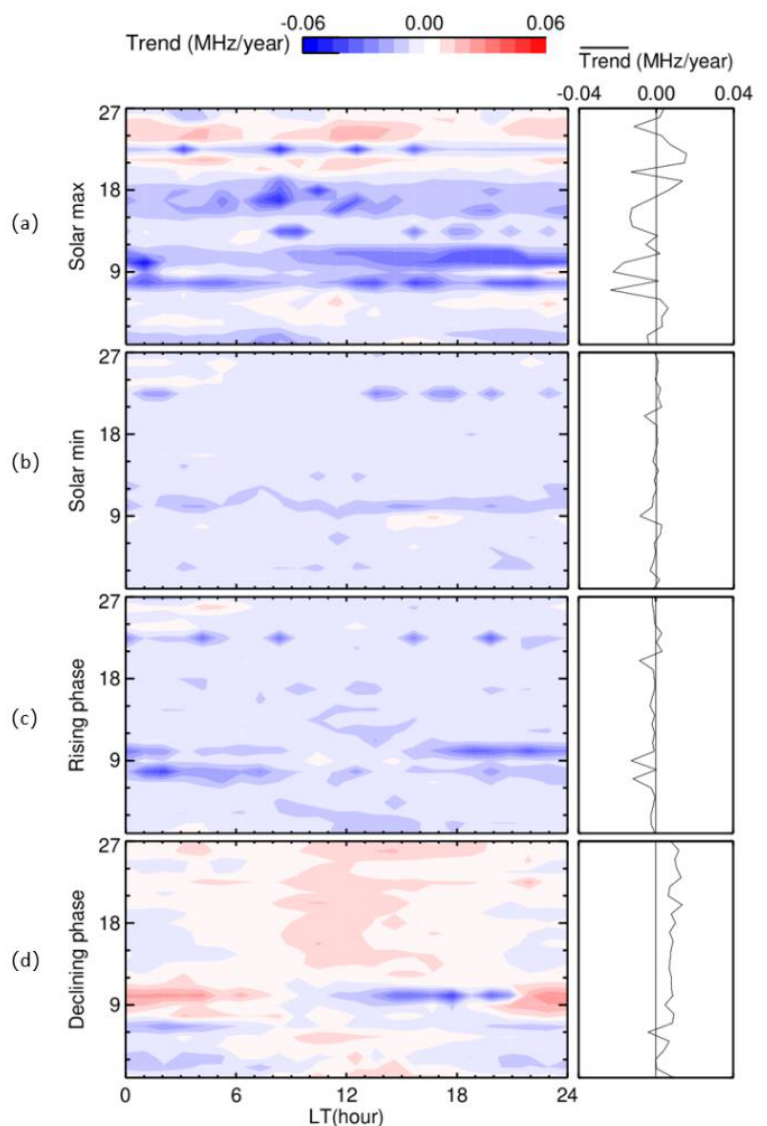
Figure 3. ( left panels ) Ge (the index reflects the effect of geomagnetic activity on ionosphere at mean level) as a function of LT (local time) at different phases of solar activity ( a – d represent solar max, solar min, rising phase, and declining phase, respectively). The x and y axes show LT and station number, respectively. ( right panels ) Means of Ge over all LT values for the different stations.